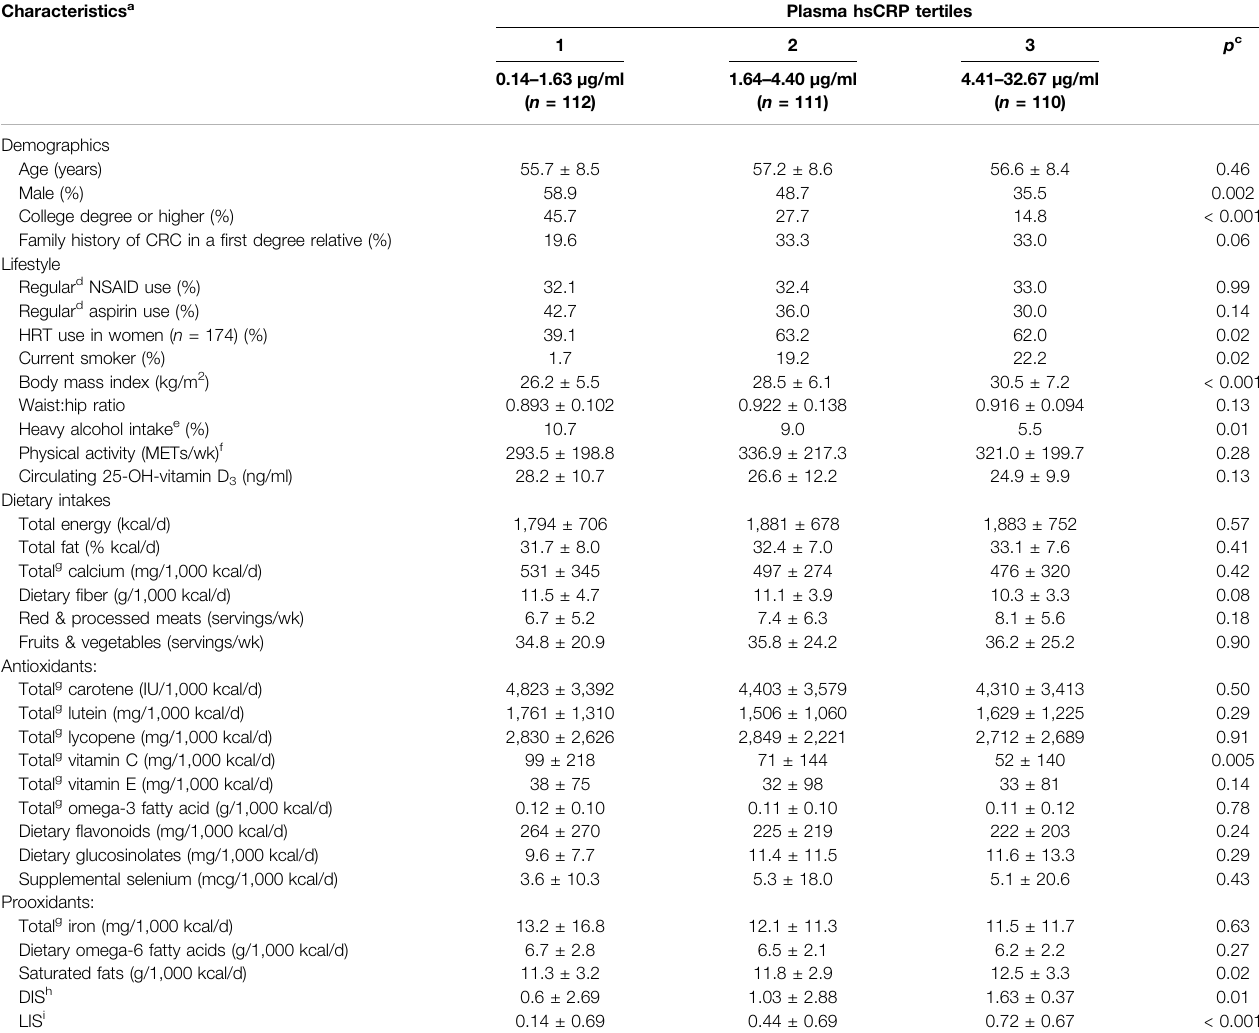
TABLE 1| Selectedcharacteristicsofparticipants ( n =333) a ,bytertilesofplasmahighsensitivityC-reactiveprotein (hsCRP),inthepooledMAPIandMAPIIcross-sectional studies b . Characteristics